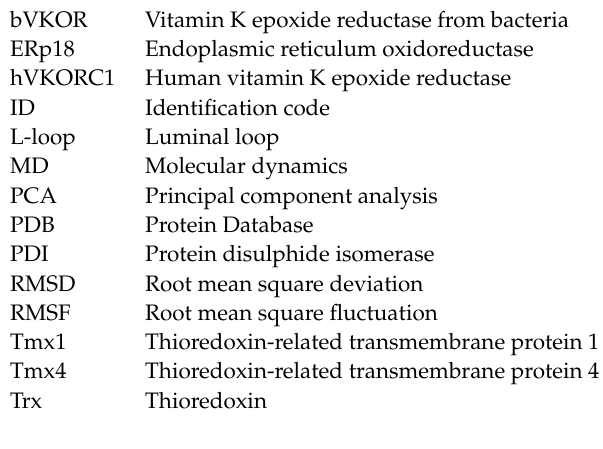
Figure S6. Folding of hVKORC1 over the MD simulations. Figure S7. Intrinsic motion of hVKORC1 and its L-loop. Figure S8. Clustering analysis of the L-loop conformations by using the ensemble- based clustering. Figure S9. The contact maps of pairwise distances C α − C α (< 10 Å) computed for each conformation from the mostly populated clusters (> 4%) found on the concatenated trajectory. Figure S10. The hydrophobic contacts (yellow dashed lines) in L-loop of hVKORC1. Figure S11. Comparison of the Trx-domain and L-loop from bVKOR with the PDI and L-loop from hVKORC1. Figure S12. Superposition of Model 1 (left) and of Model 2 (right) of the PDI-hVKORC1 complex into the structure of bVKOR (PDB ID: 4NV5). Figure S13. Modelling of the human PDI-VKORC1 complex and their MD simulations. Figure S13. Intermolecular contacts at the interface between PDI and hVKORC1 in the Model 1 of the PDI-hVKORC1 complex. Figure S14. Intermolecular contacts